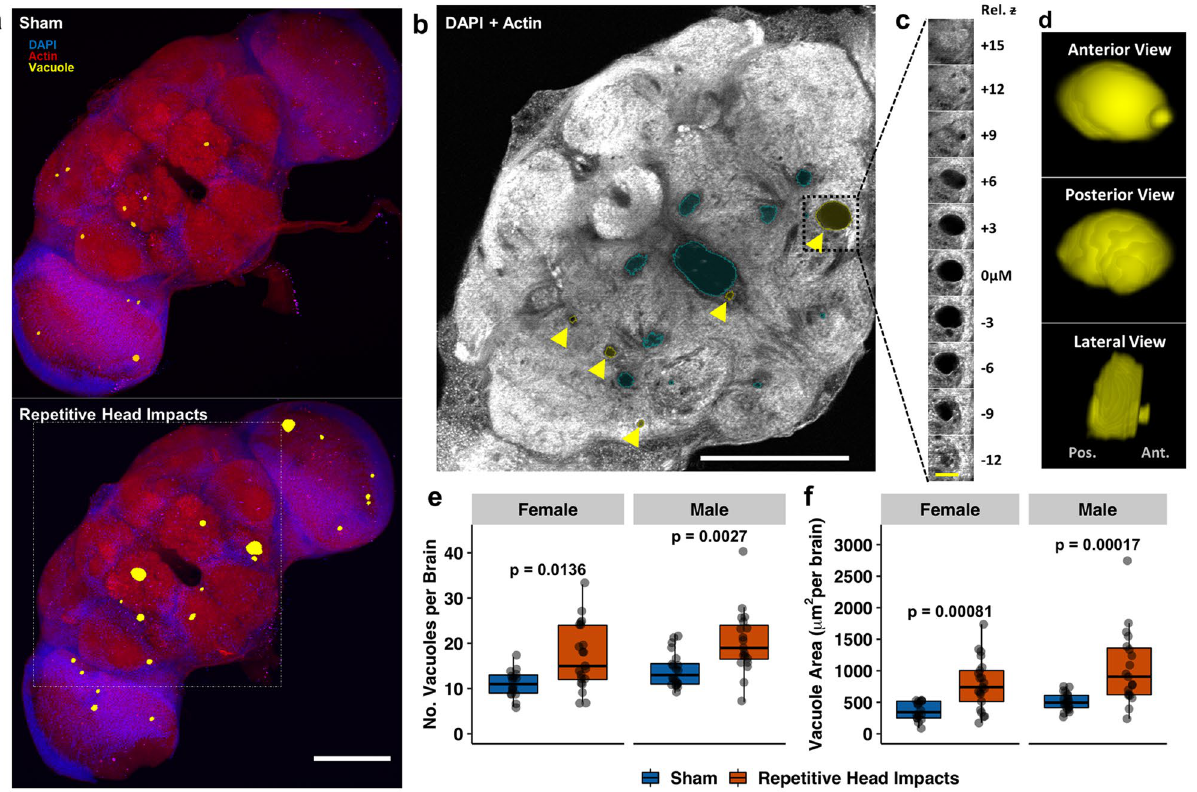
Figure 4. Repetitive head impacts exacerbate age-related neurodegeneration five weeks after injury. (a) Representative max projection of whole-brain slices (1 µm thick) imaged using two-photon microscopy with brain vacuoles (neurodegeneration) depicted as yellow overlays which correspond to regions devoid of DAPI (blue) and phalloidin (red) signal from a (Top) sham injury brain and (Bottom) a repetitively injured brain, captured five weeks following repetitive head impact exposure (2 sessions of 15 impacts). ( b) Representative two-photon microscopy slice from white square outline of injured brain in ( a ) where pathological vacuoles of varying size (enclosed within yellow outline with yellow arrow) are found throughout the midbrain while blue outlines designate physiologically normal holes. ( c,d) Representative vacuole outlined in ( b) is depicted in ( c) as a series of z-stack images and ( d) 3-D reconstruction of the vacuole. ( e,f) Quantification of (e) vacuole number and ( f) vacuole area per brain from sham and repetitively injured brains. Boxplots contain individually plotted values with whiskers corresponding to the maximum 1.5 interquartile range. Within sex differences between sham and repetitive head impact conditions were analyzed with the Mann–Whitney U test with Bonferroni correction. White scale bar = 100 µm, yellow scale bar = 20